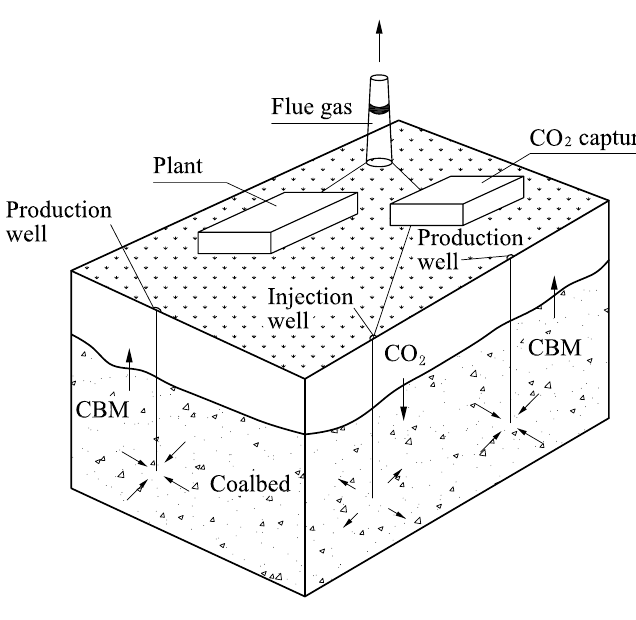
Figure 13. ECBM conceptual